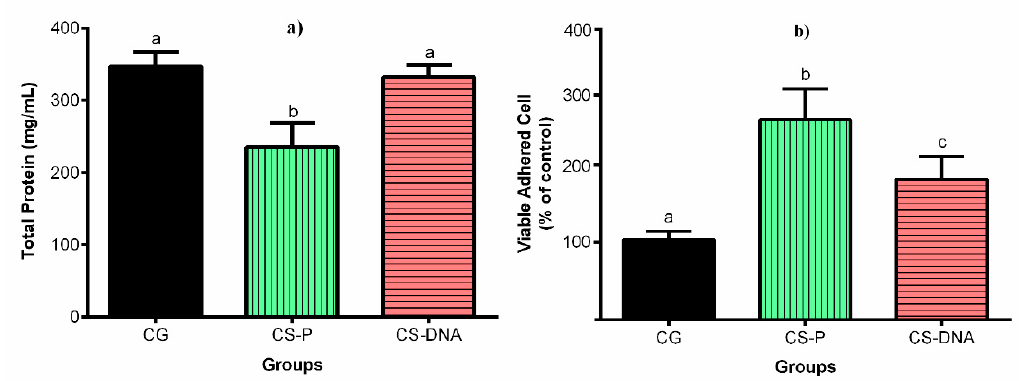
Figure 5. Mean ± SD for in vitro tests for ( a ) measurement of cell viability MTT assay and ( b ) total protein production. Values that do not share the same superscript letters are significantly different from each other ( p < 0.05).